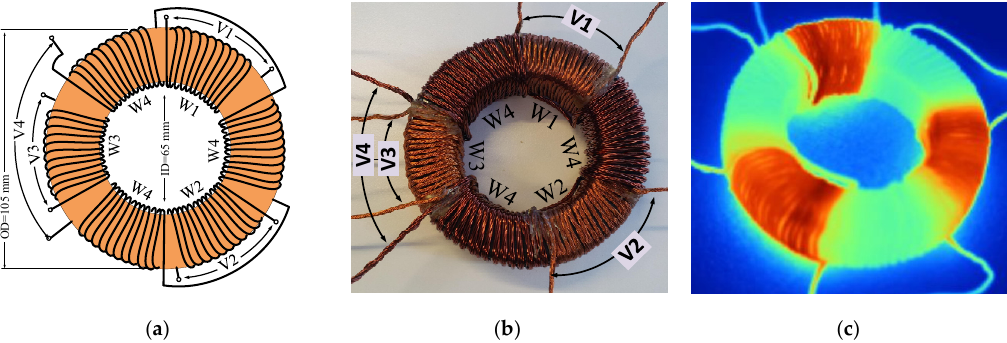
Figure 8. (a) Dimension of designed transformer, ( b ) the experimentally developed transformer and ( c ), the transformer under the thermal test using thermal camera. ( c ), the transformer under the thermal test using thermal